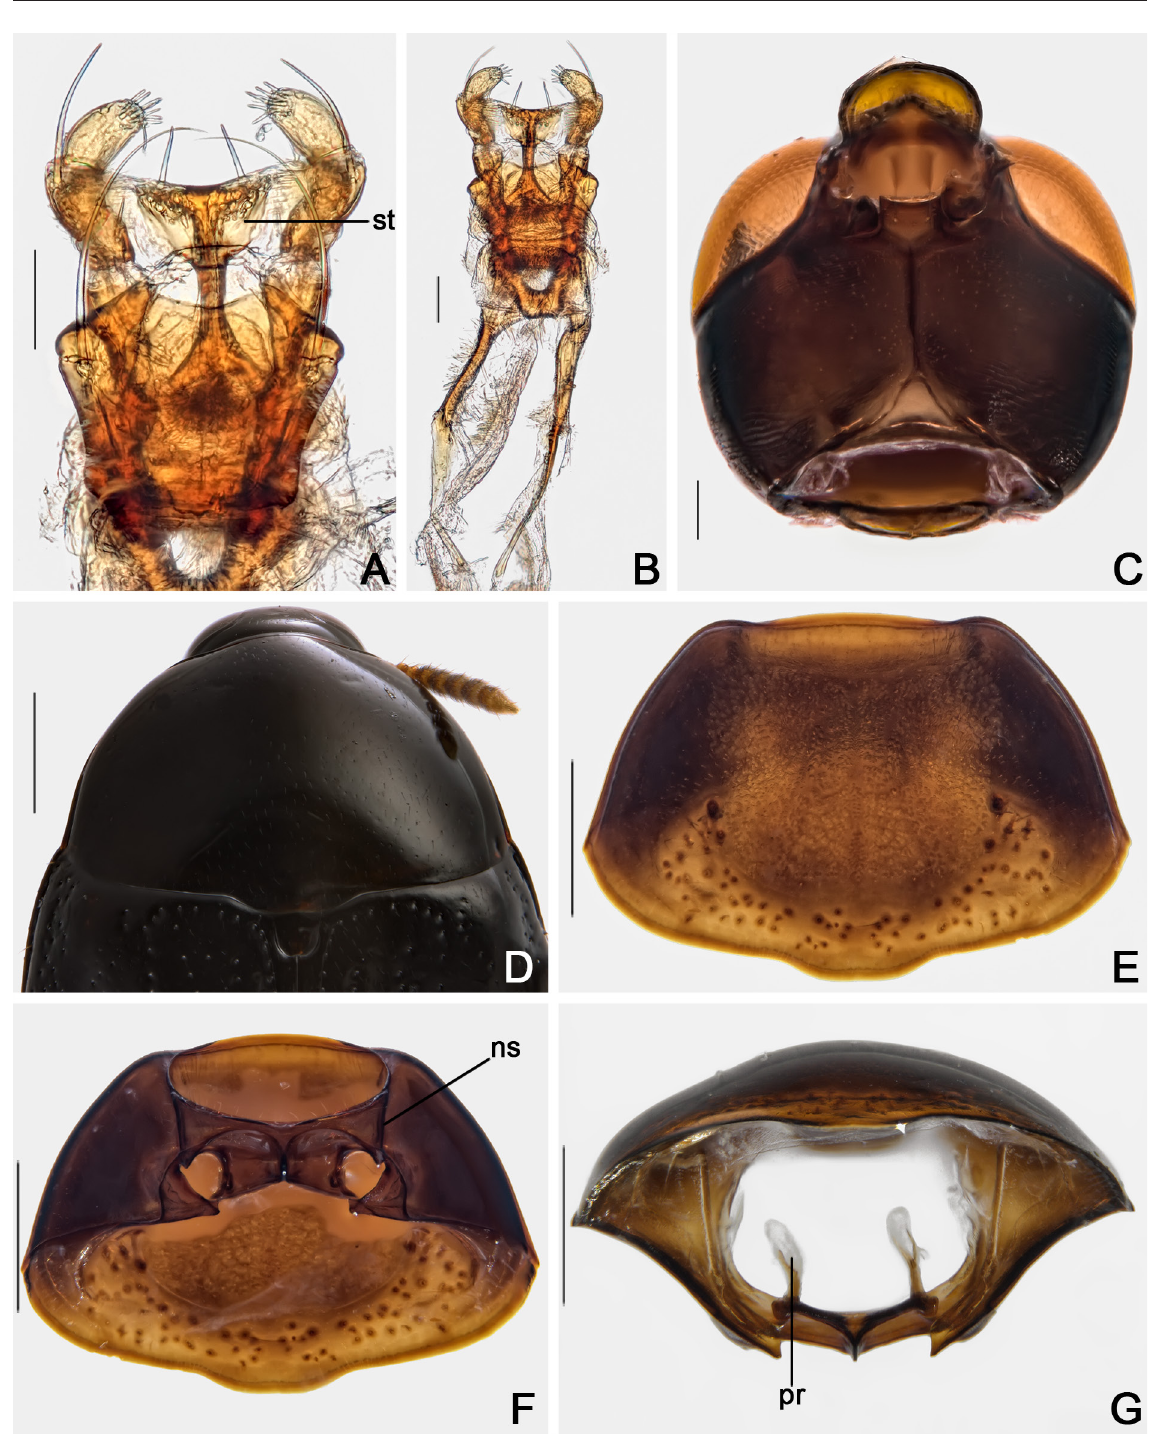
Fig. 8. Cyparium achardi sp. nov. A–C. Paratype, ♂ (CELC). A . Labium. B . Hypopharynx. C . Head, ventral view. D . Holotype, ♂ (CELC), pronotum, dorsal view. E–G . Paratype, ♂ (CELC), prothorax. E . Frontal view. F . Ventral view. G . Inner view. Specimens collected at Mata do Paraíso, Viçosa (MG, Brazil). Abbreviations: ns = notosternal suture; pr = profurca; st = sclerotized plate. Scale bars: A–B = 0.05 mm; C = 0.1 mm; D–G = 0.5